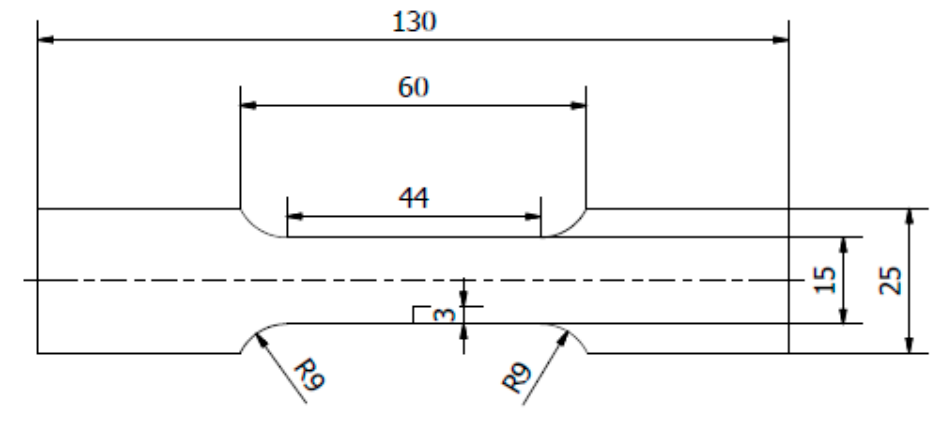
Figure 1. The geometry of a notched sample.